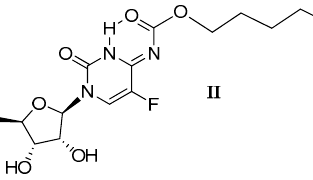
Figure 3. The preferred structure of imine tautomer II with the -C(=O)-O-C 5 H 11 chain rotated around the C4-N7 bond by 180°, according to the X-ray measurements. An intramolecular N3-H···O(C8) hydrogen bond appears.